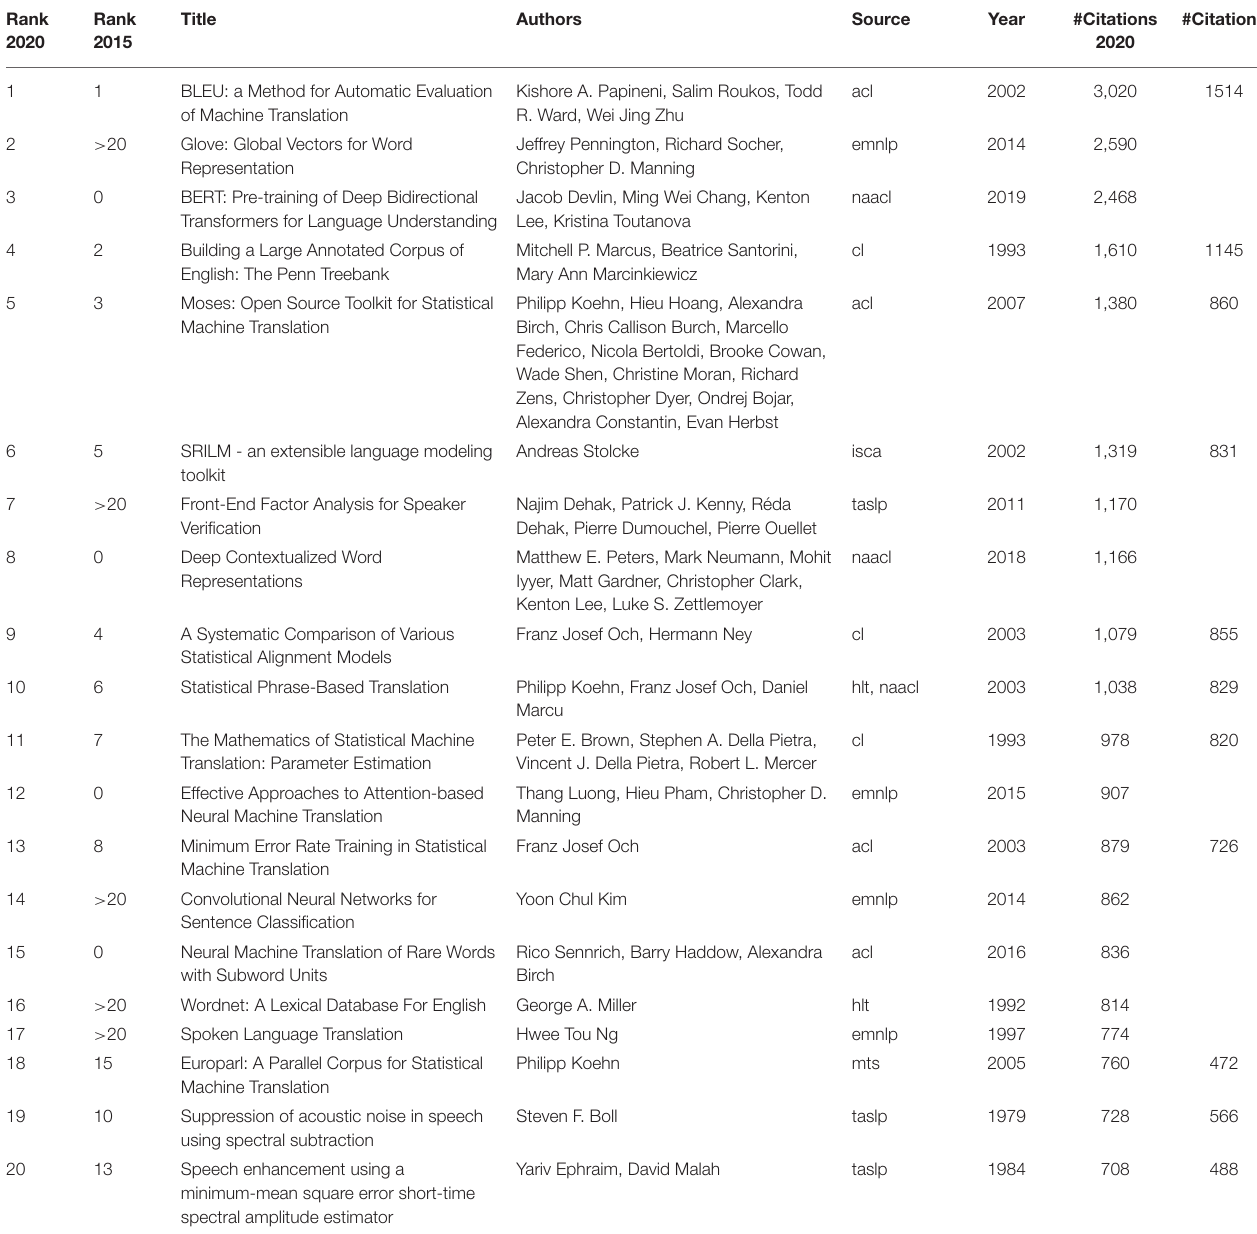
TABLE 18 | The number of 20 most cited papers up to